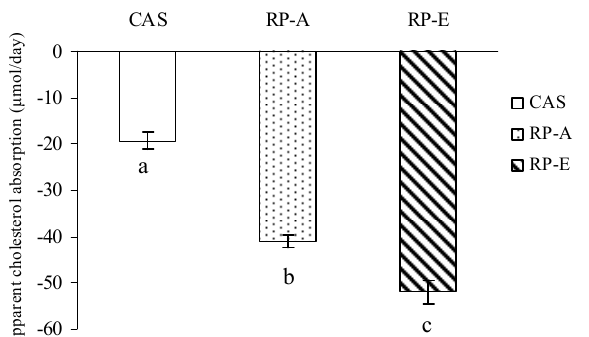
Figure 3. Apparent cholesterol absorption in growing rats fed cholesterol-free diets. Values are means ± SEM ( n = 6). Bars for each value with different letters were significantly different ( P <